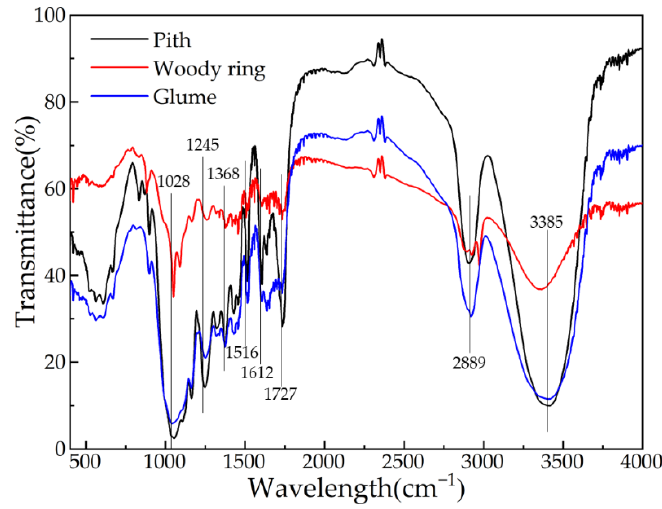
Figure 6. FTIR of three-layer components of corn cob.